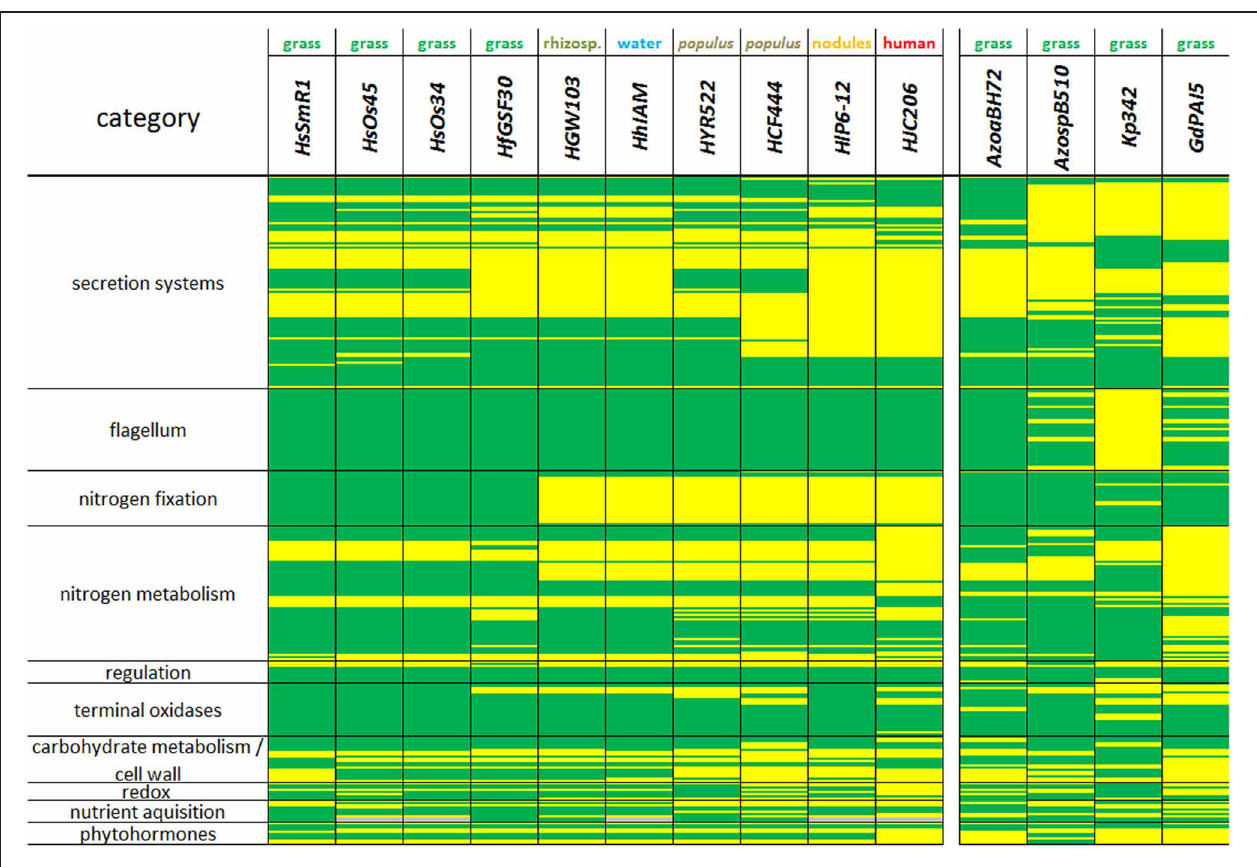
FIGURE 3 | Similarity and divergence of gene clusters reflecting various cell functions, including secretion systems, cell wall, nitrogen, carbon, and hormone metabolism in Herbaspirillum and endophyte strains. Present genes are schown in green, lacking genes are shown in yellow, missing information is given in gray. Strains from left to right: HsSmR1 , Herbaspirillum seropedicae SmR1; HsOs34 , Herbaspirillum seropedicae Os34; HsOs45 , Herbaspirillum seropedicae